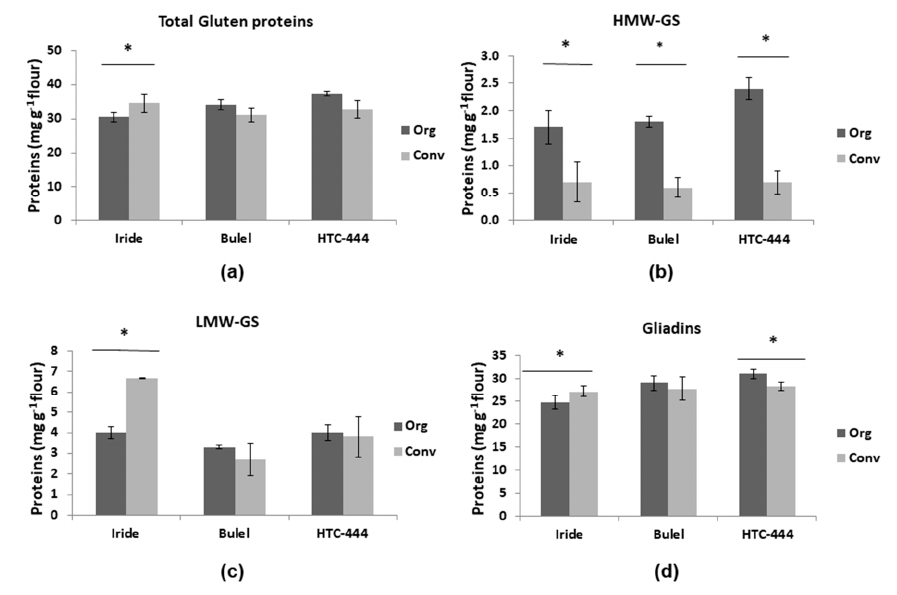
Figure 2. Total gluten content ( a ) HMW ‐ GS ( b ) LMW ‐ GS ( c ) and gliadin ( d ) fractions of durum